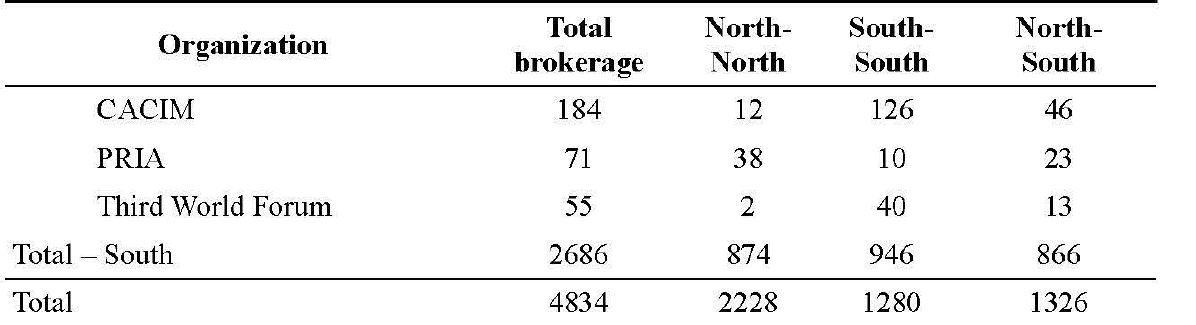
Table 7. Relations brokered by TAPGs between North and South